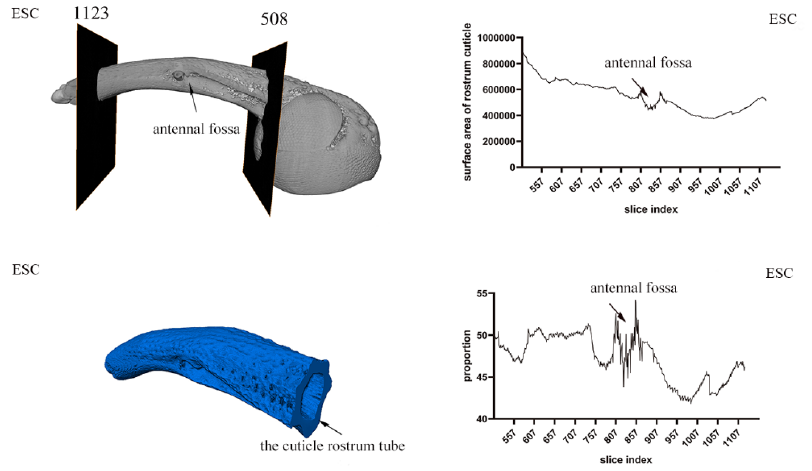
Figure 5. The rostral cuticle thickness of Eucryptorrhynchus scrobiculatus (ESC) females. The left is the three-dimensional reconstruction structure of the rostrum tube by micro-CT; the right is the change of the thickness of the rostral cuticle.